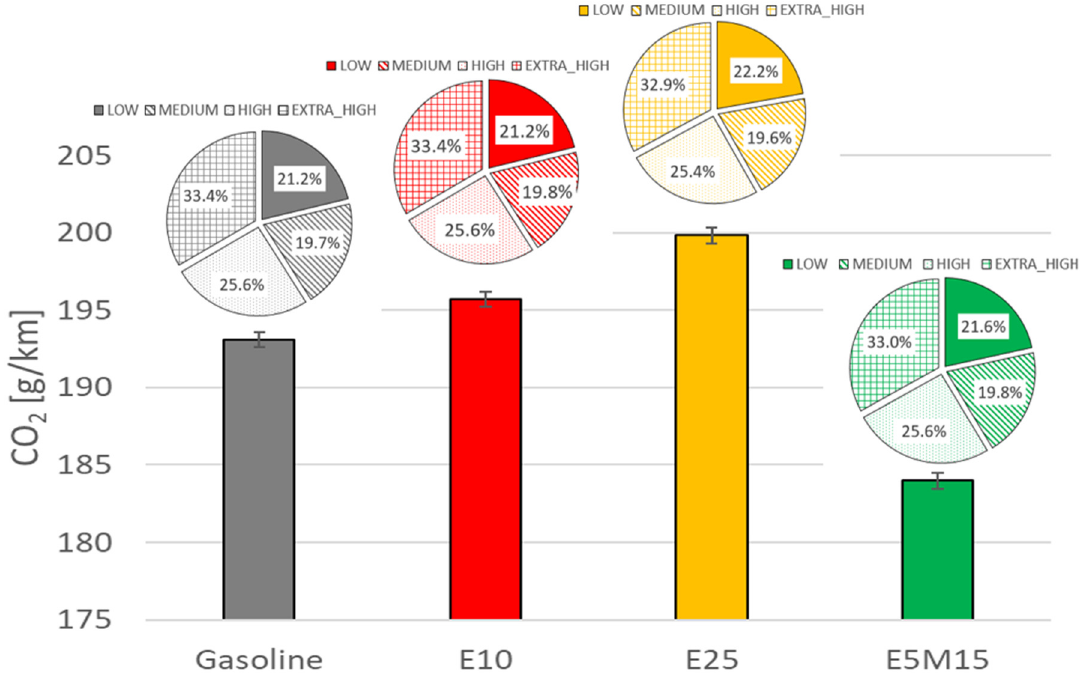
Figure 5. CO 2 emissions measured at each phase of the cycle for gasoline, E10, E25 and E5M15.